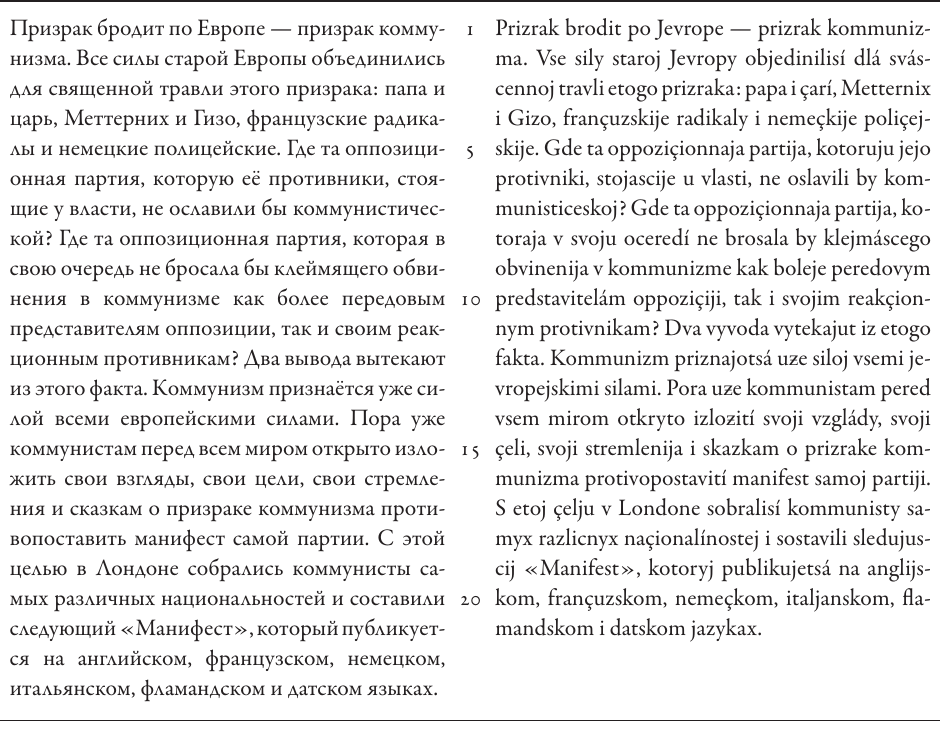
Fig. 3. Economic Latin